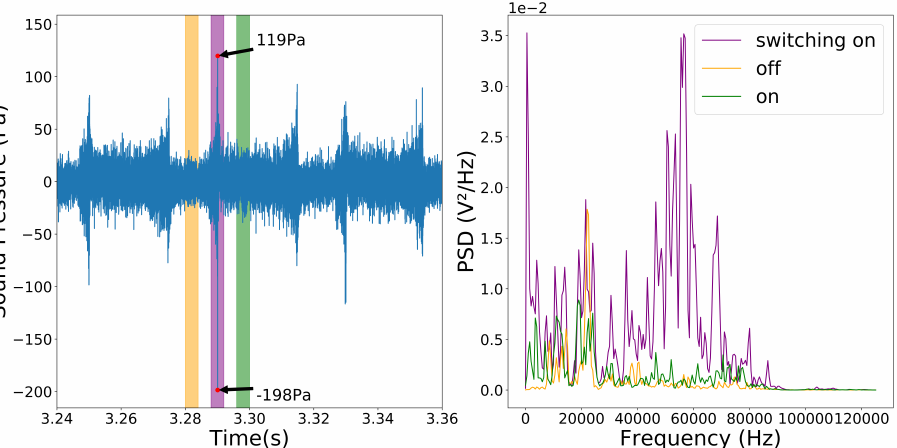
Figure 3. Time series of the sound pressure and power density spectrum (PSD) measured with the inital